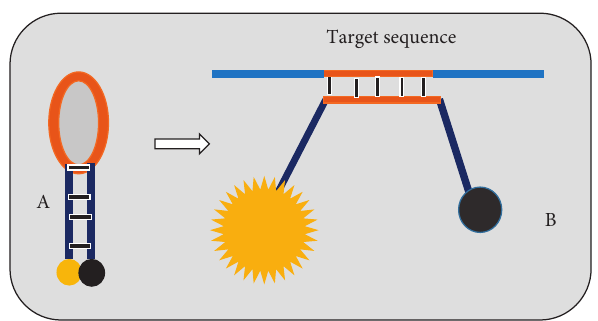
Figure 2: Diagram of molecular beacon. (A) The molecule forms hairpin when free in solution. This brings fluorophore (yellow ball) and quencher (black ball) in close proximity, so that no fluorescent light is detected. (B) The molecule hybridizes to the target sequence. This separates the fluorophore and quencher and leads to emission of fluorescent